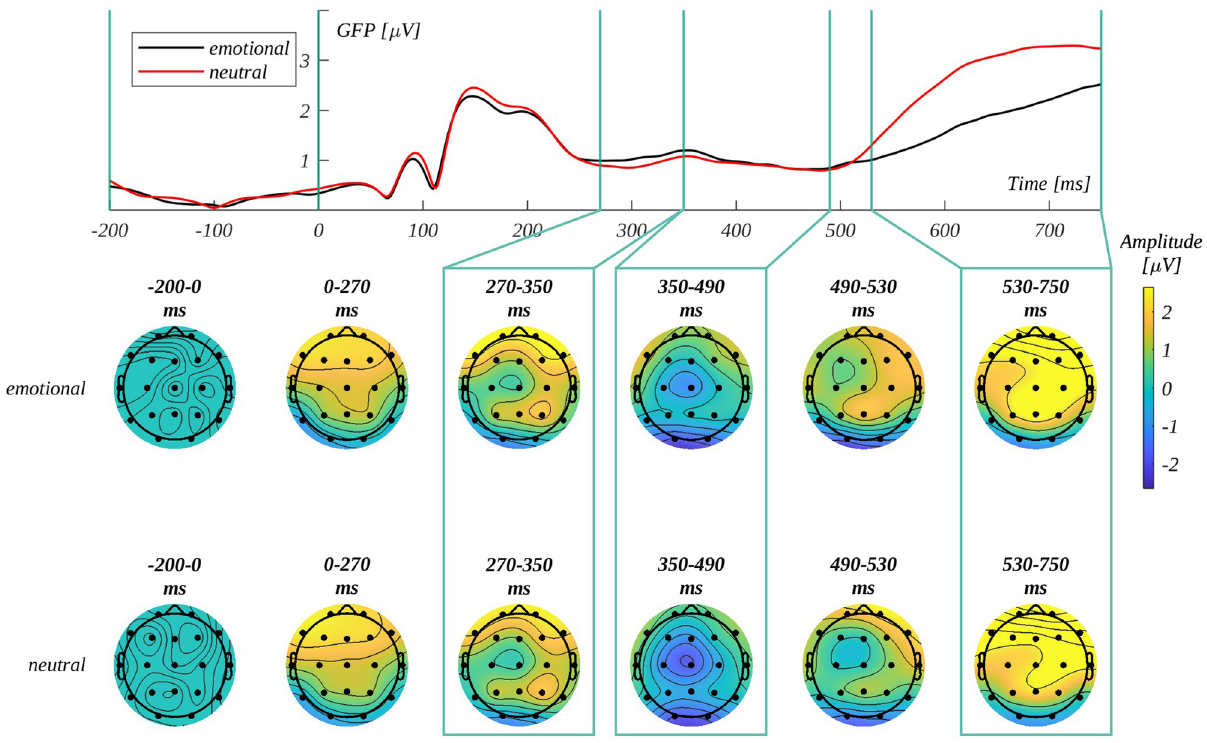
Fig 10. Analysis of global field power. Top—Global Field Power (GFP); middle and bottom—topographical distribution of mean potential in consecutive time windows for emotional and neutral stimuli as assessed by the participants in the case of emotional and neutral stimuli respectively.